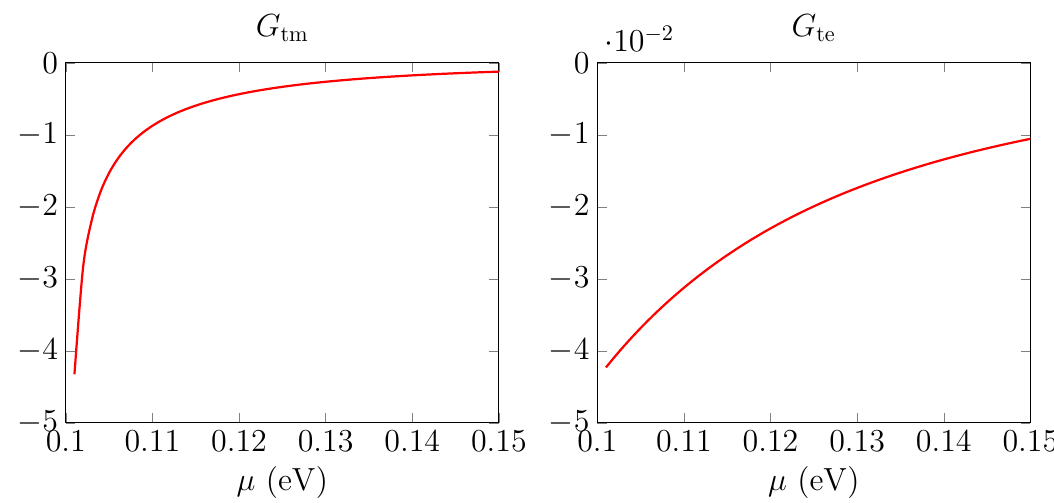
Figure 3. The functions G x (30a) for different values of the chemical potential µ > m . The numerical evaluation of H x ( a ) for a = 100 nm gives the following values H tm = 3 10 6 and H te = 0.18. Again, the main contribution comes from TM mode. The value of × H tm strongly depends on the value of the Fermi velocity. For v F The temperature contribution for µ temperatures, the free energy has the form of parabola, with negative parameter G tm (see Figure 3).